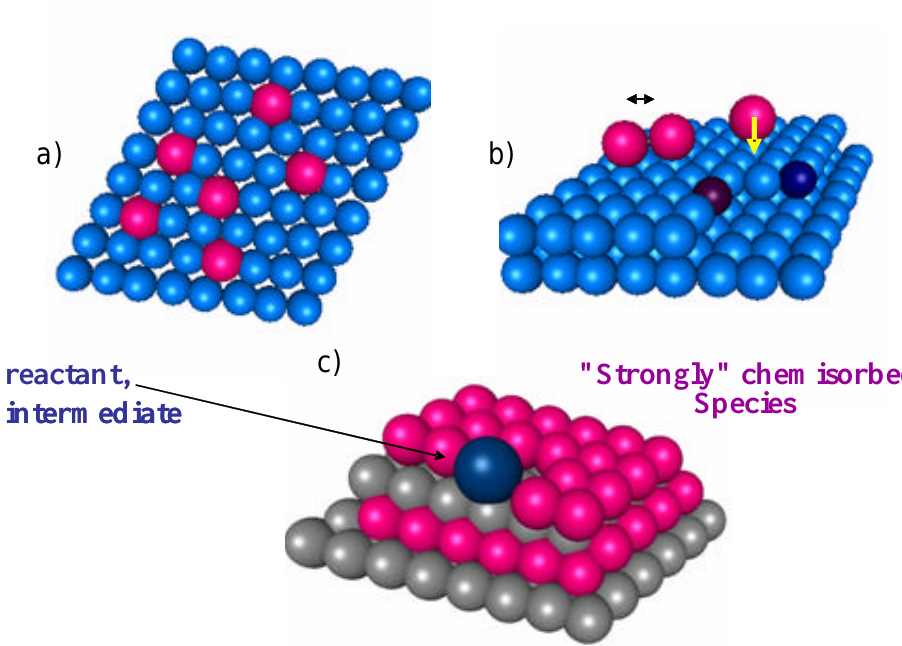
Figure 1. Schematic model of the "ideal" Langmuir surface (a), of a simple model of real sur- face with kinks and steps, surface interaction between adsorbates and electron donation of a chemisorbed molecule to catalyst conduction band (b), and of a working catalyst surface with the largest part of the surface occupied from "strongly" chemisorbed species